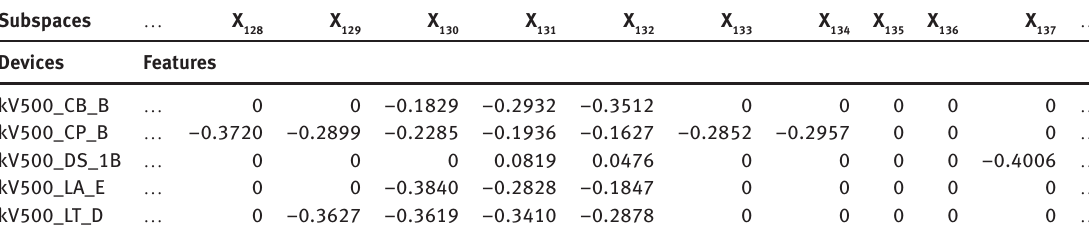
Table 1: Feature Vectors of Five Devices.